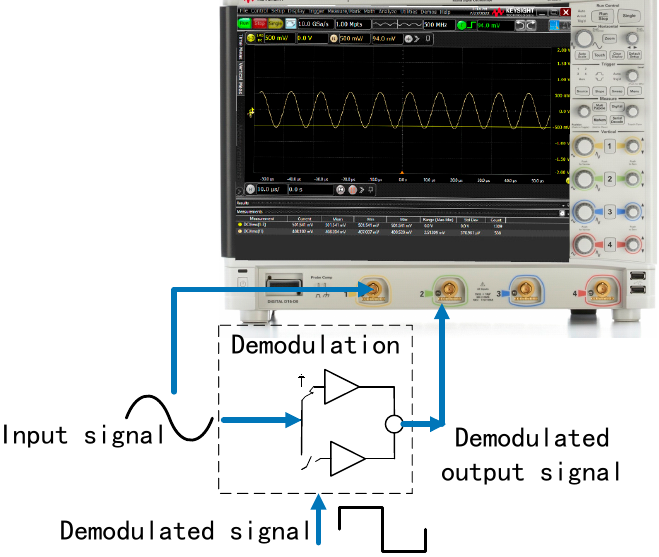
Figure 13. Test connection diagram of demodulation circuit.